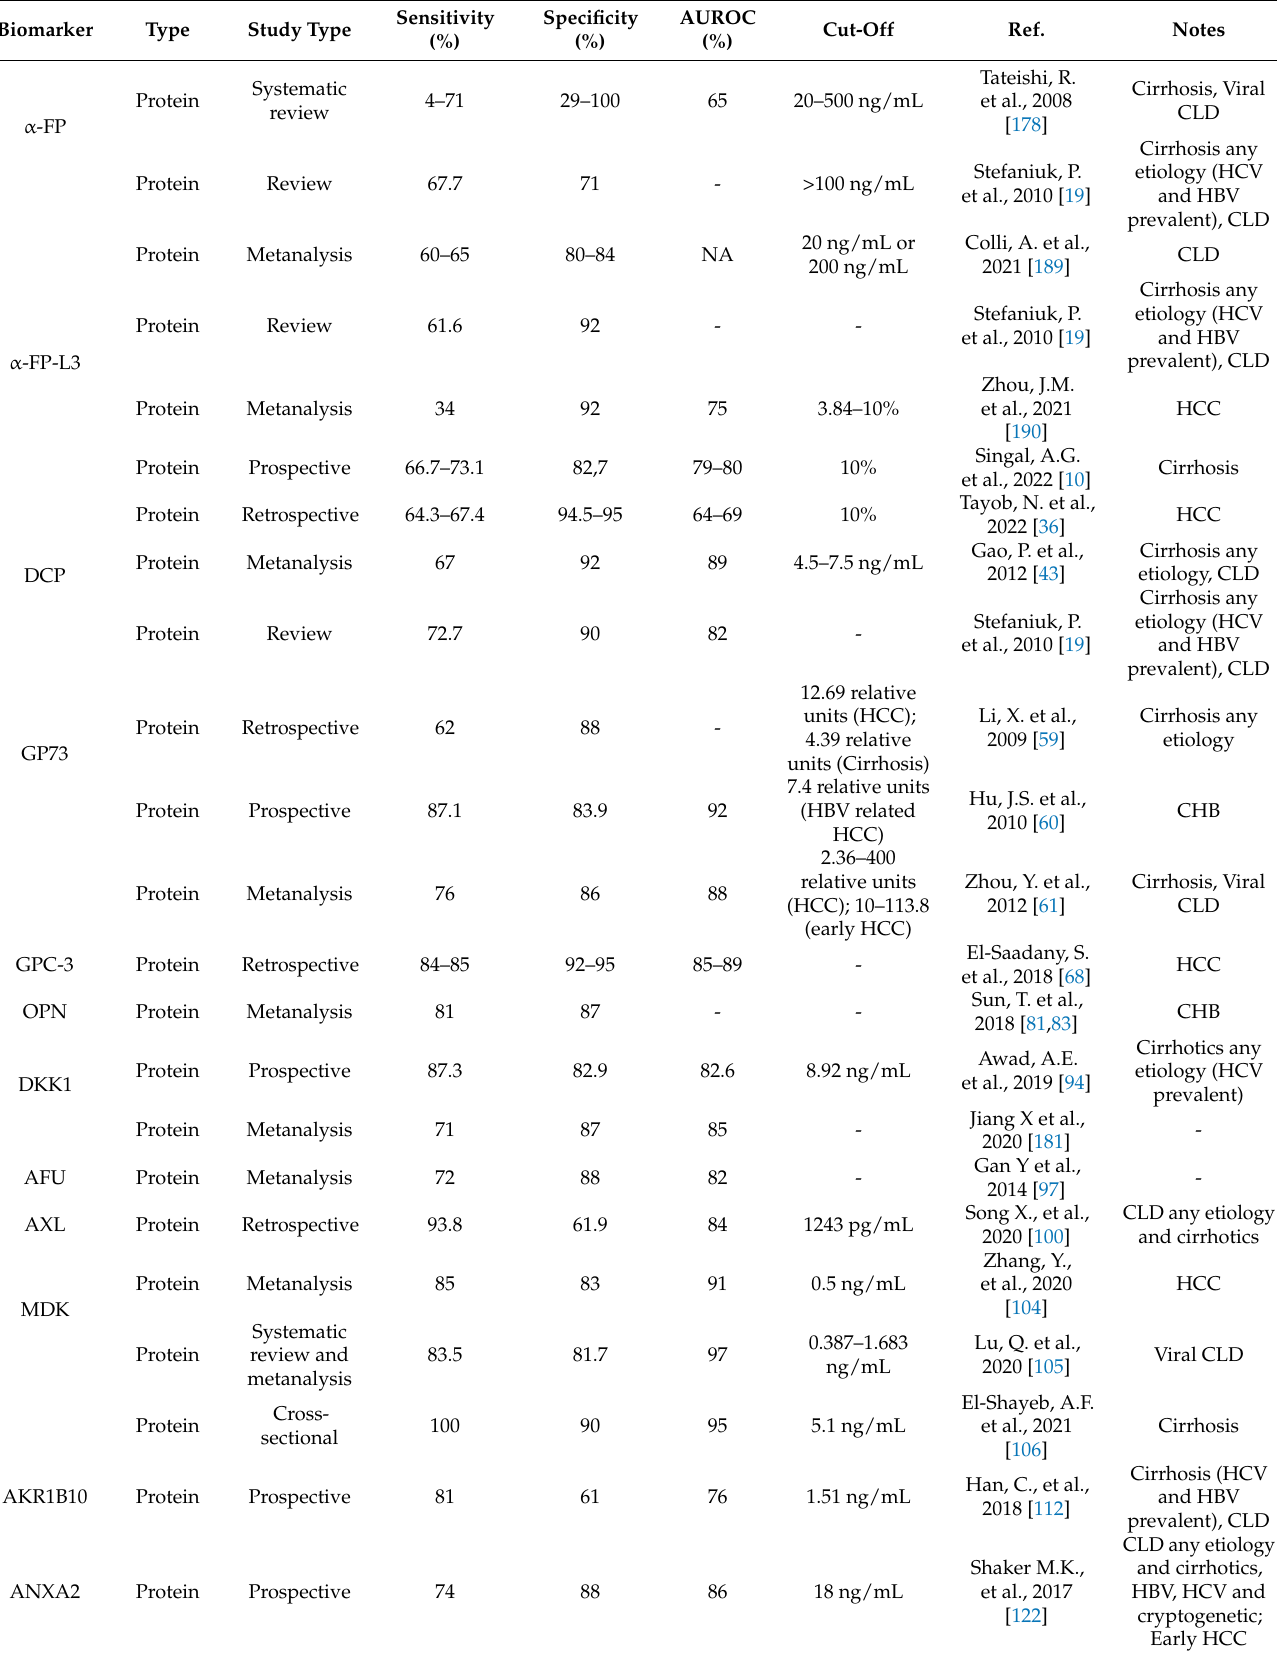
Table 1. Example of candidate HCC diagnostic biomarkers. Sensitivity, specificity and AUROC shown as percentages